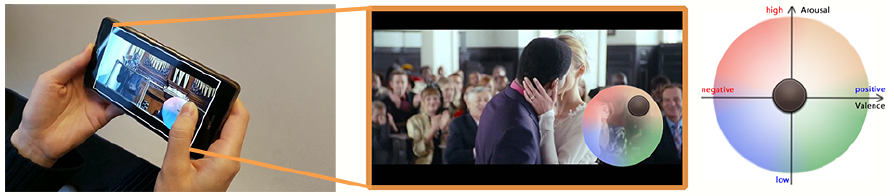
Figure 5. The real-time and continuous V-A annotation interface (cf., [32]) used for